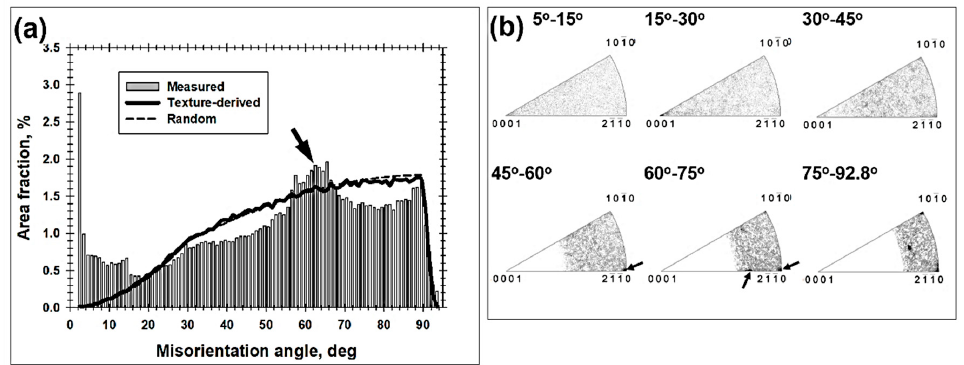
Figure 7. Distributions of ( a ) misorientation angle and ( b ) rotation axis for the α phase derived from the EBSD data in Figure 4b. The arrows show the misorientations which presumably originated from an α → β → α s phase transformation.